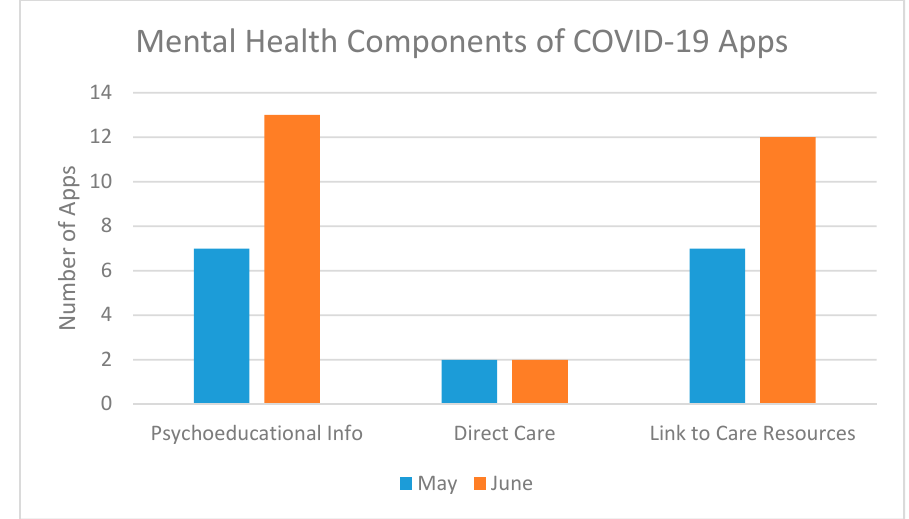
Figure 3. Mental Health Components of COVID-19 Apps. An increasing number of COVID-19 apps